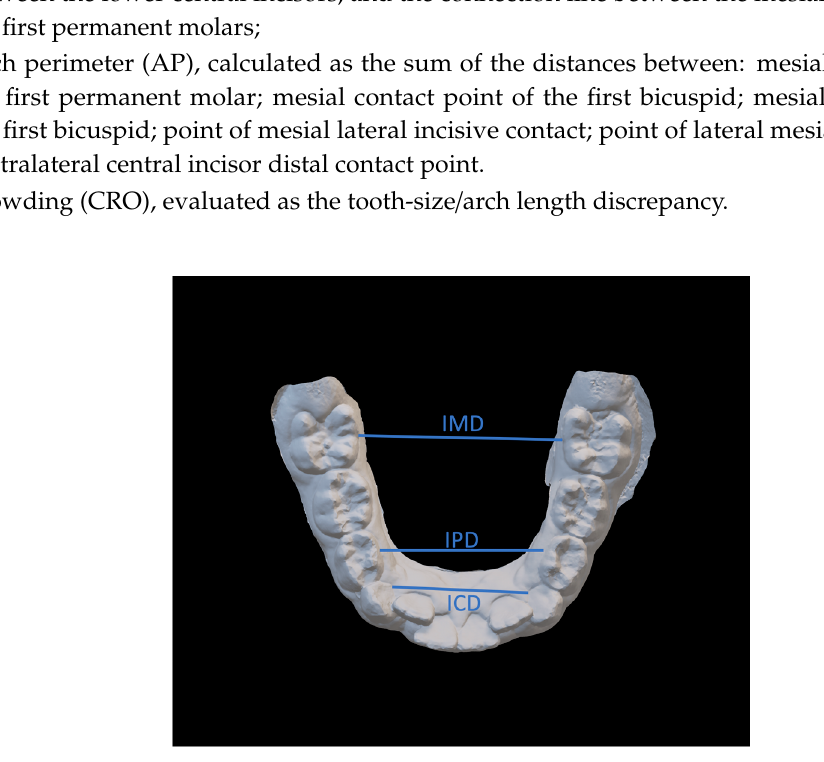
Figure 3. Intercanine distance (ICD), interpremolar distance (IPD), intermolar distance (IMD).